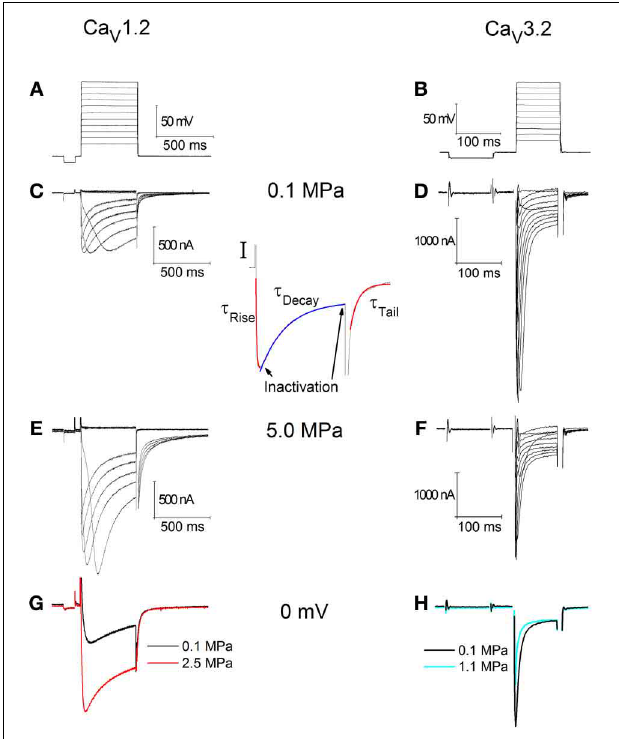
FIGURE 1 | Currents recorded in Ca V 1.2 (C,E,G) and Ca V 3.2 (D,F,H) channels. (A) Depolarization steps for (C,E) . (B) Depolarization step for (D,F) . (C,D) Ba 2 + currents at 0.1MPa. (E,F) Ba 2 + currents at 5.0MPa. Note current increase in (E) at HP and decrease in (F) . (G,H) Superimposed single current traces under normo- and hyperbaric conditions, in response to identical depolarization to 0mV. (I) Indication of the corresponding sections of the currents used to calculate the inactivation and kinetics